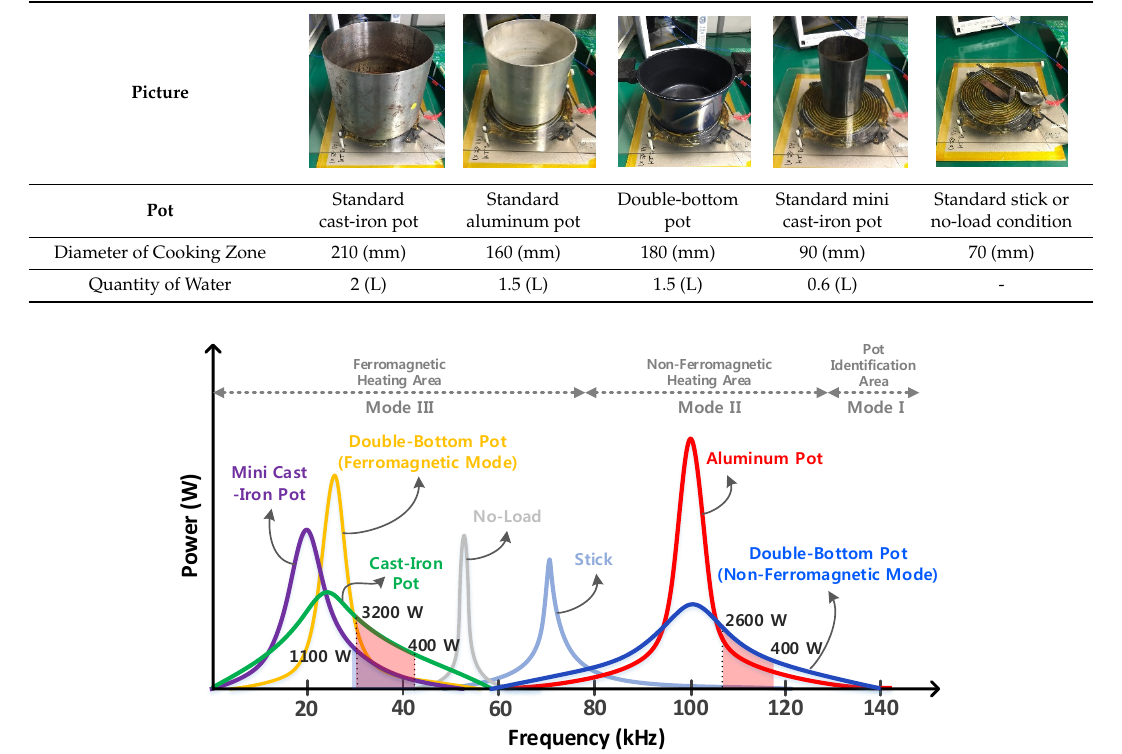
Figure 5. Input power curve according to pot type and frequency variation.